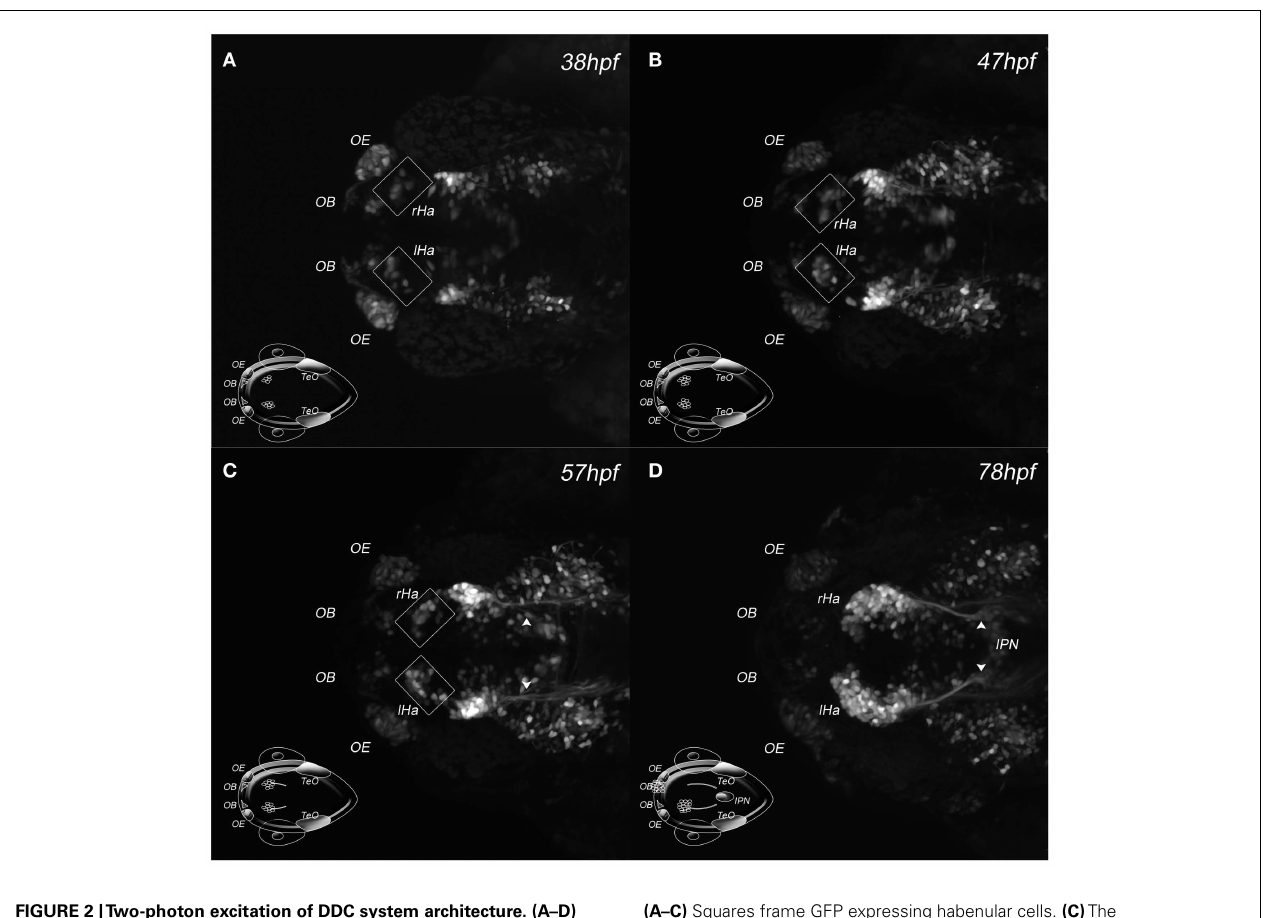
FIGURE 2 |Two-photon excitation of DDC system architecture. (A–D) Maximum intensity projections of four developmental stages acquired by in vivo 2PM of a Et(-1.0otpa:mmGFP)hd1 transgenic zebrafish embryo; dorsal views, anterior left; developmental stages are indicated.The cartoon inserts show regions of GFP expressing cells for orientation.